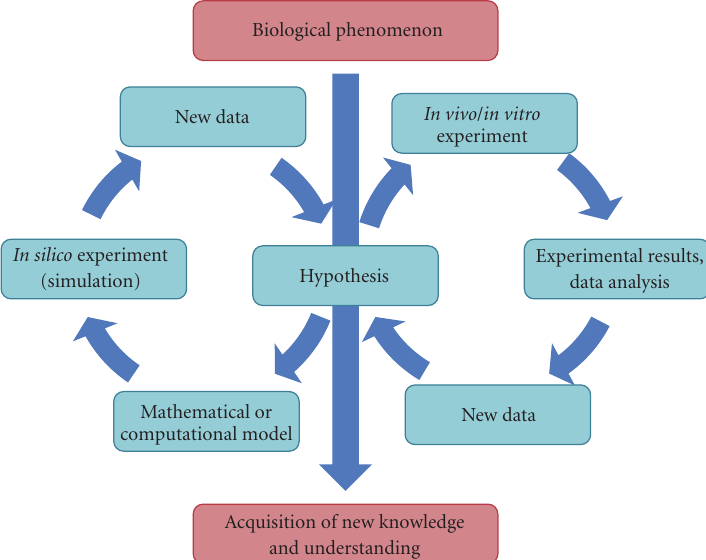
Figure 1: Steps in knowledge generation in system biology. Knowledge on a given biological phenomenon is generated in a stepwise manner by combining modeling and experimental techniques. A model is built up enabling the researcher to perform in silico experiments in order to predict the behavior of the biological system under given conditions. These predictions have, in turn, to be validated via in vivo or in vitro systems, leading to further refinement of the model and the underlying hypothesis. Table 1: Examples of possible data sources for model building and refinement. Experimental results from the literature or own laboratory Databases Experimental